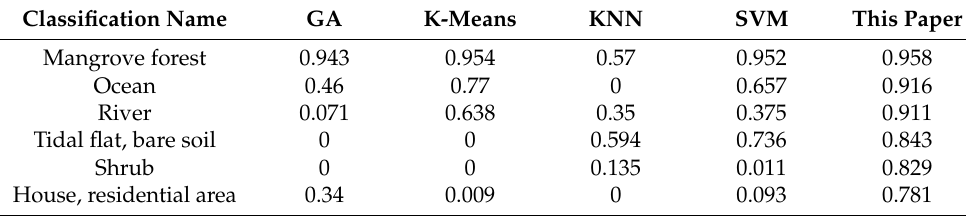
Table 7. Test Results for Accuracy (P) Parameter (Data 3).